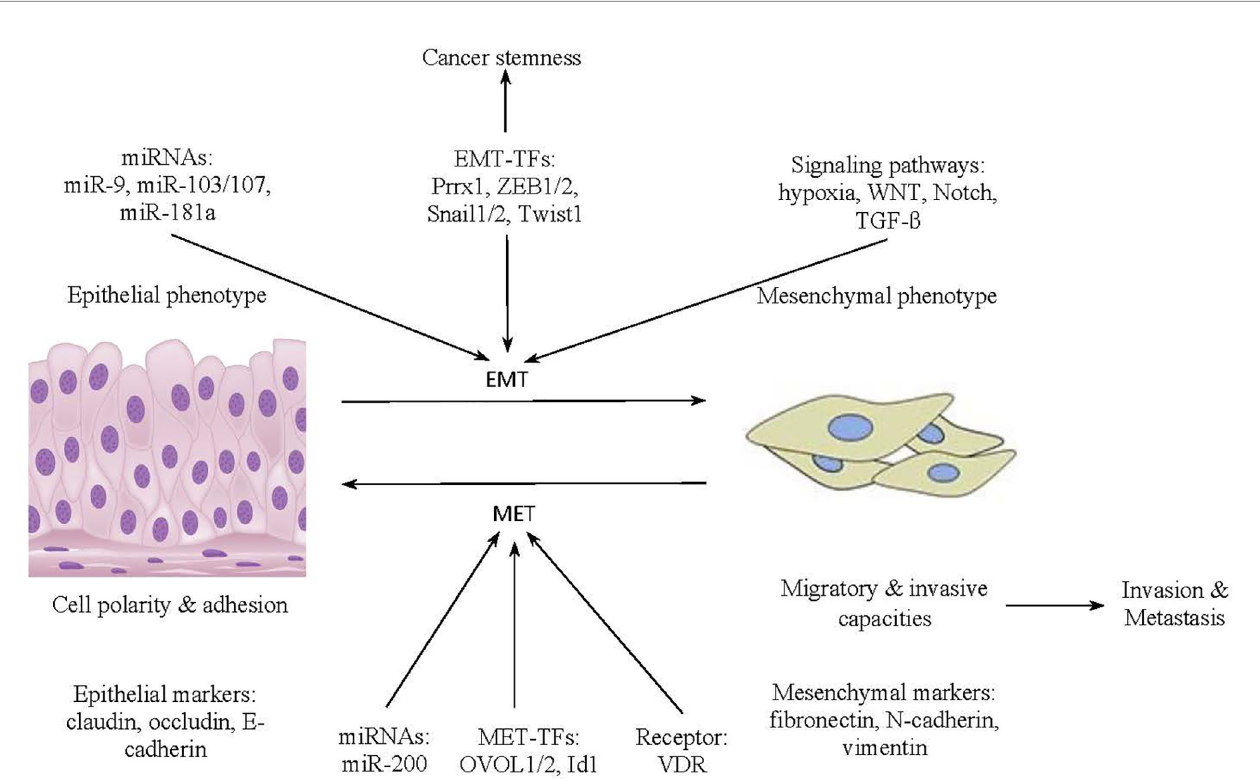
FIGURE 1 | The transformation from the epithelial to the mesenchymal phenotype in cancer